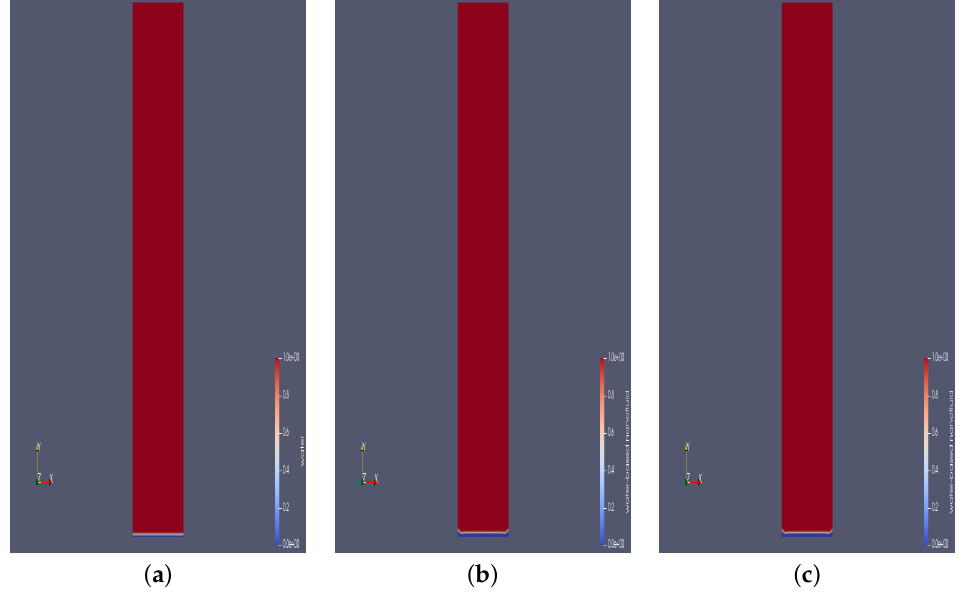
Figure 10. Snapshot of solutions for multi-phase mixtures at time t = 2.5 s. ( a ) Water. ( b ) Water-Al 2 O 3 nanofluid. ( c ) Water-TiO 2 nanofluid.